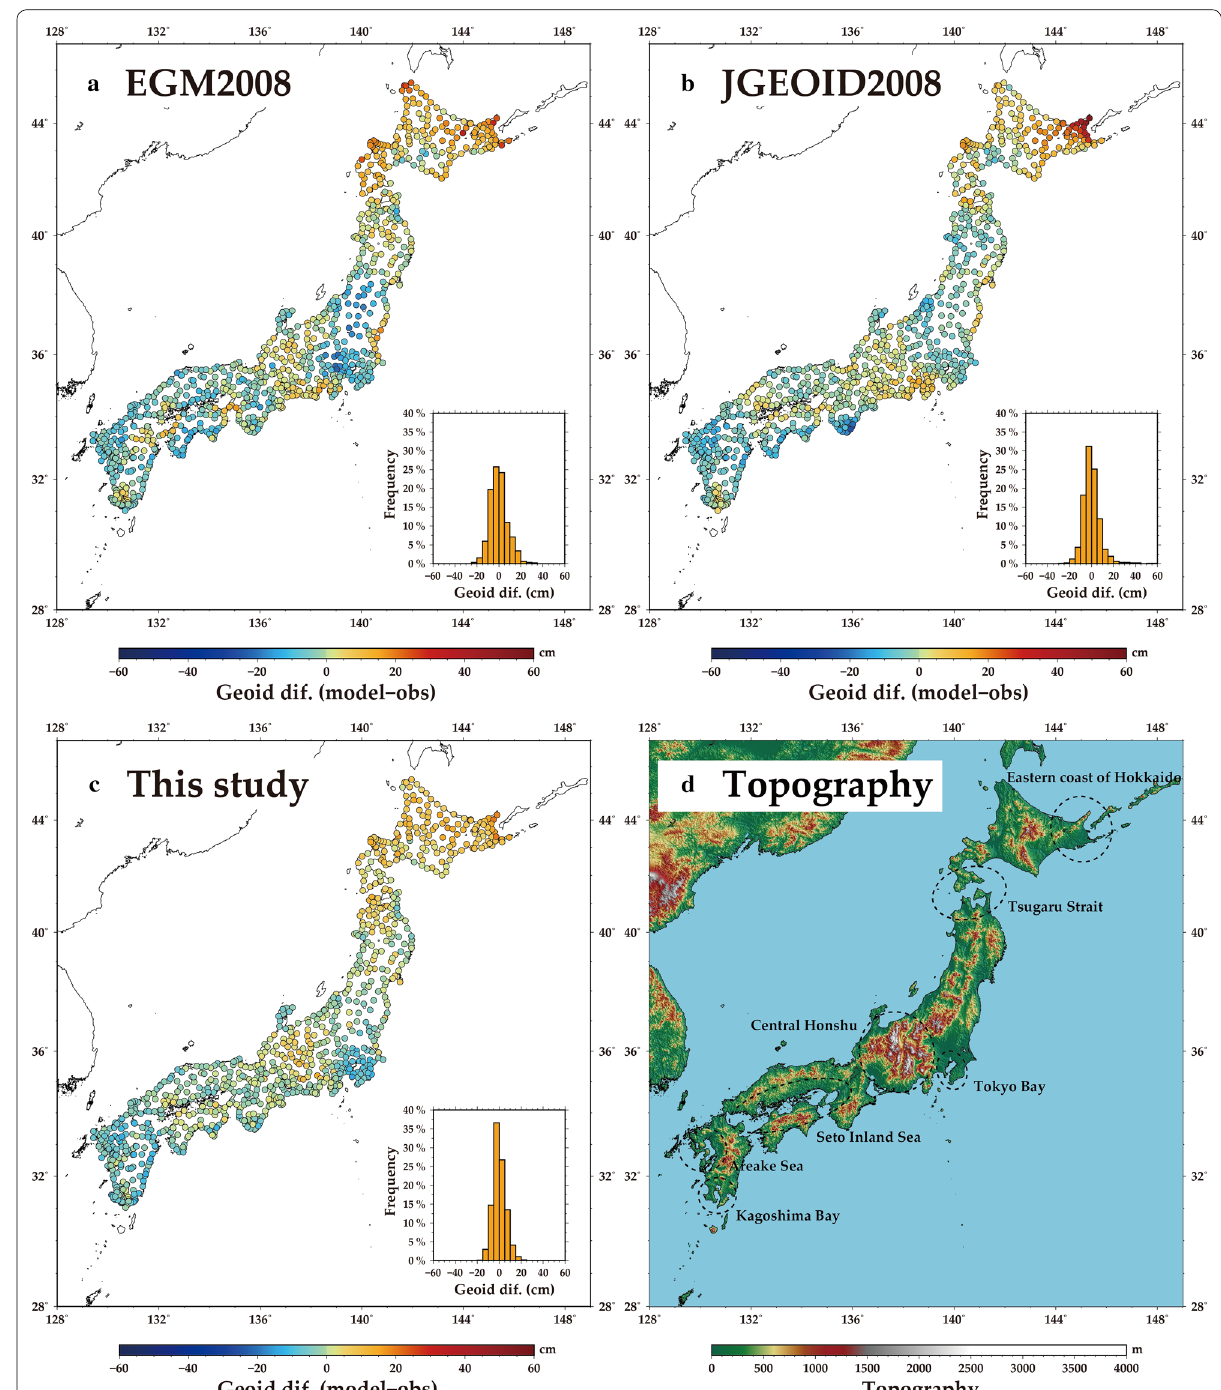
Fig. 5 a – c Geographical map of difference between gravimetric geoid models and GNSS/leveling geoid heights. The mean value of each geoid difference was subtracted from each model. The graphs inside each figure are histograms of the geoid difference from the mean value, whose horizontal axis represents the geoid difference and vertical axis shows the frequency of the geoid difference for each bin width of 5 cm. d Geographical map of the topography of Japan, in which the locations with large geoid discrepancies were